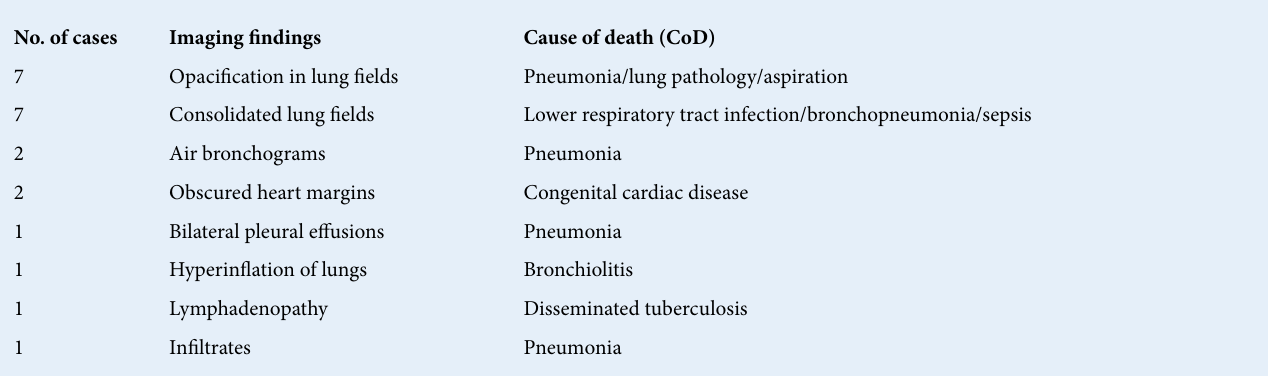
Table 1. Comparison of imaging findings and autopsy results for 22 cases for which pathology was found on imaging No. of cases